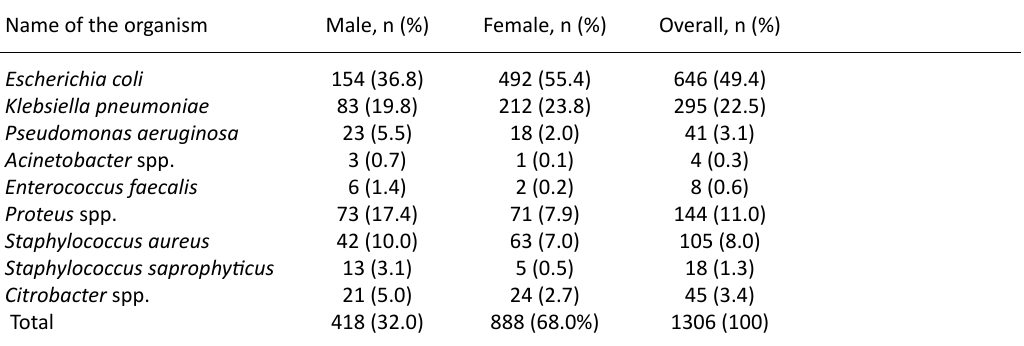
Table 1. Gender based categorisation of several uropathogens in culture positive specimens Name of the organism